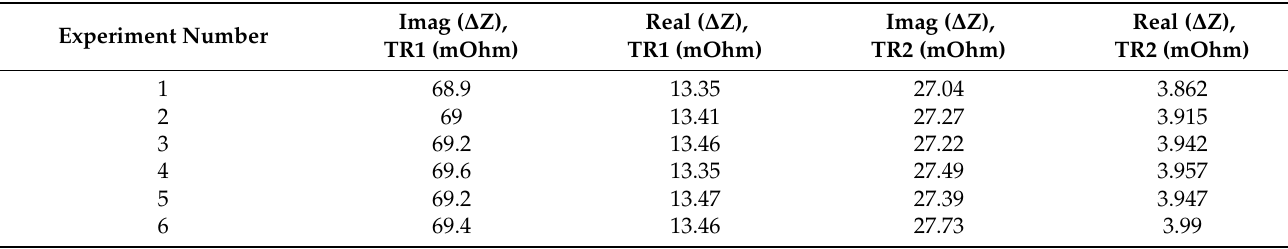
Table A1. Raw data of impedance change, planar copper metal at a lift-off of 1